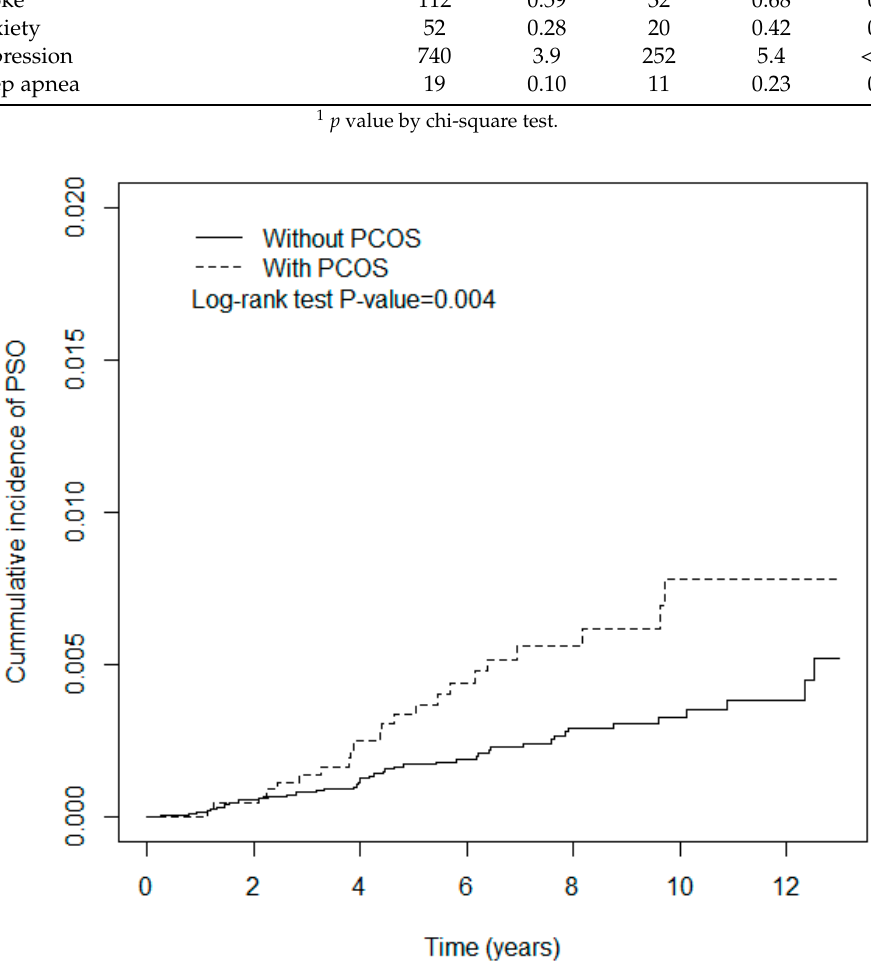
Figure 1. Cumulative incidence of psoriasis for patients with and without PCOS. Table 2. Incidence rates and hazard ratios of psoriasis.